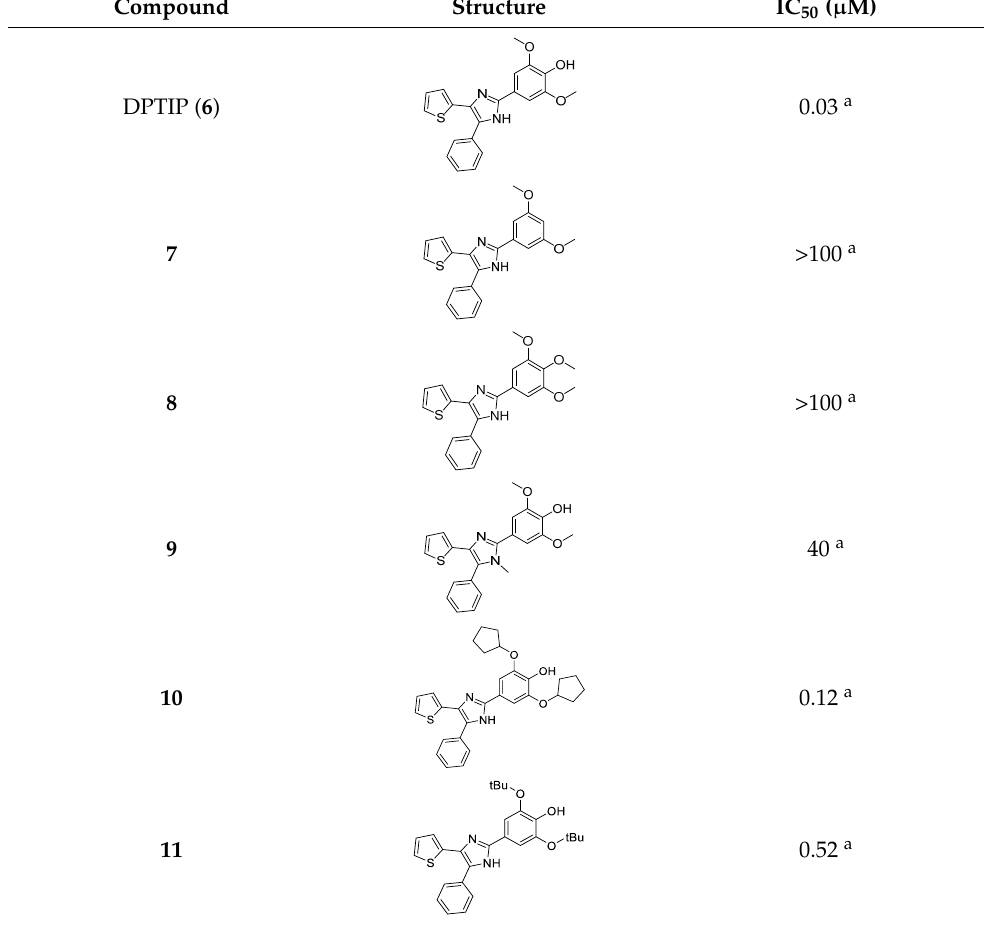
Table 2. Data from Fpocket prediction for the selected putative binding sites.